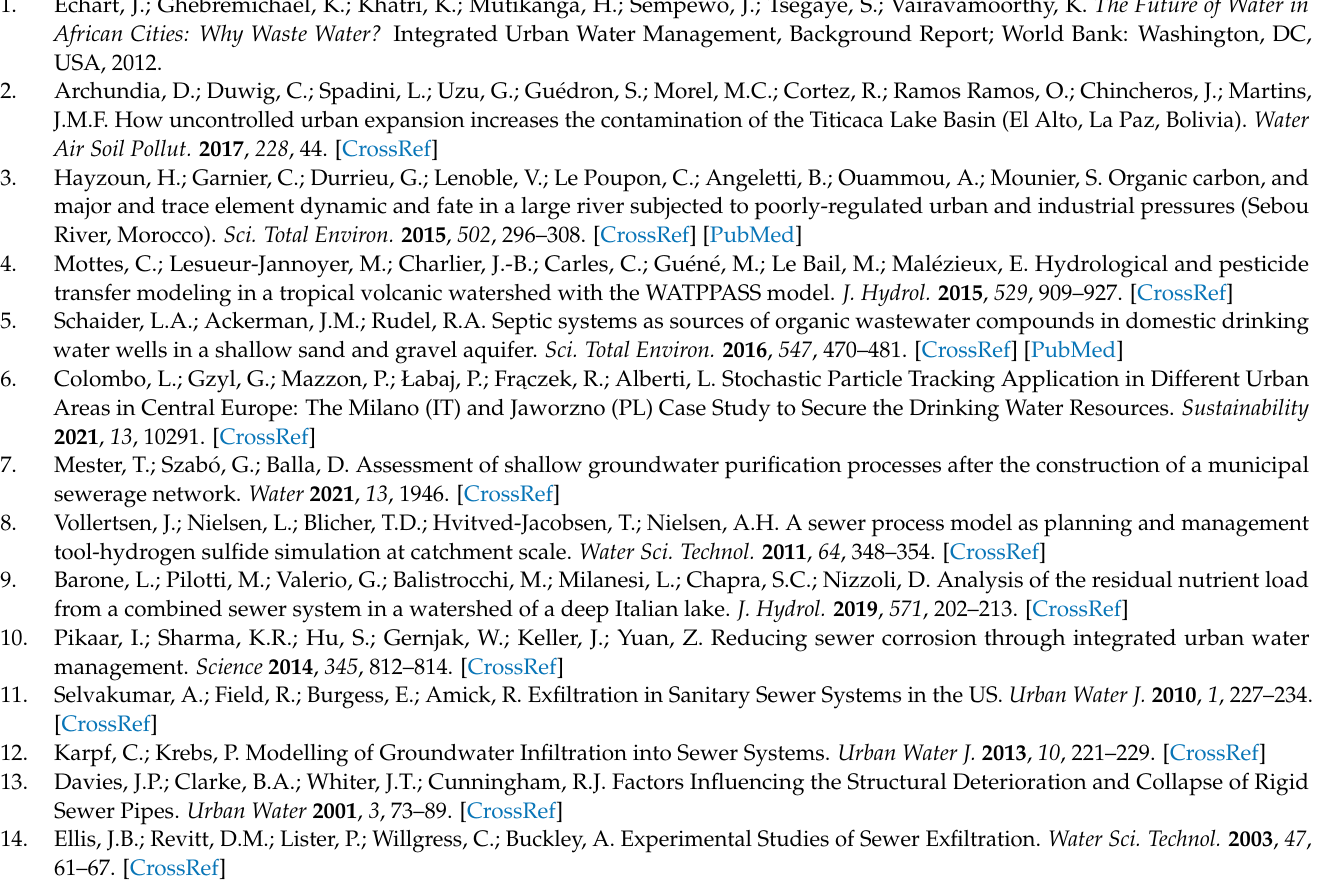
Figure S4 Genus level microbial community composition in samples collected from groundwater and wastewater. Table: Table S1 Monthly monitoring of fecal contamination indicators. Reference [93] is cited in the supplementary